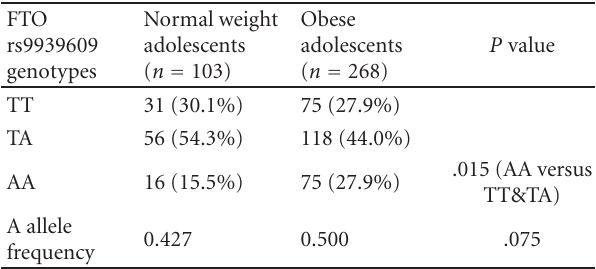
Table 2: Occurrence of the rs9939609 FTO gene polymorphism within the experimental